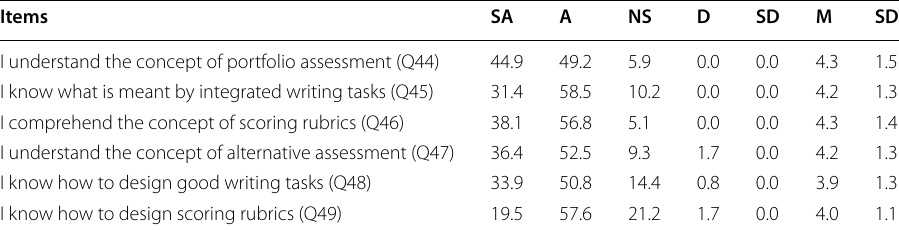
SA strongly agree, A agree, NS not sure, D disagree, SD strongly disagree